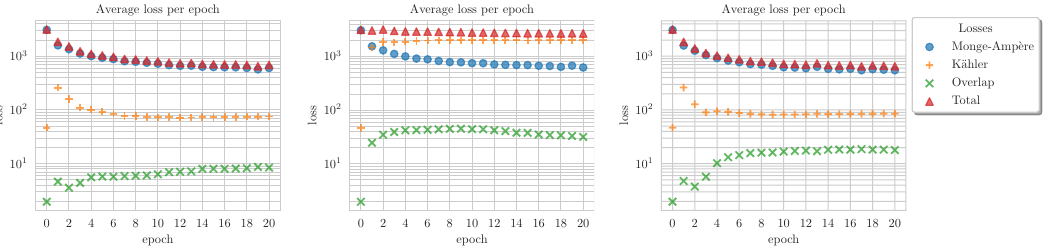
Figure 5 . Evolution of the training loss during training. ( Left ): optimizing the NN with all three losses. ( Middle ): optimizing the NN without Kähler loss (i.e. λ without overlap loss (i.e. λ = 0 3